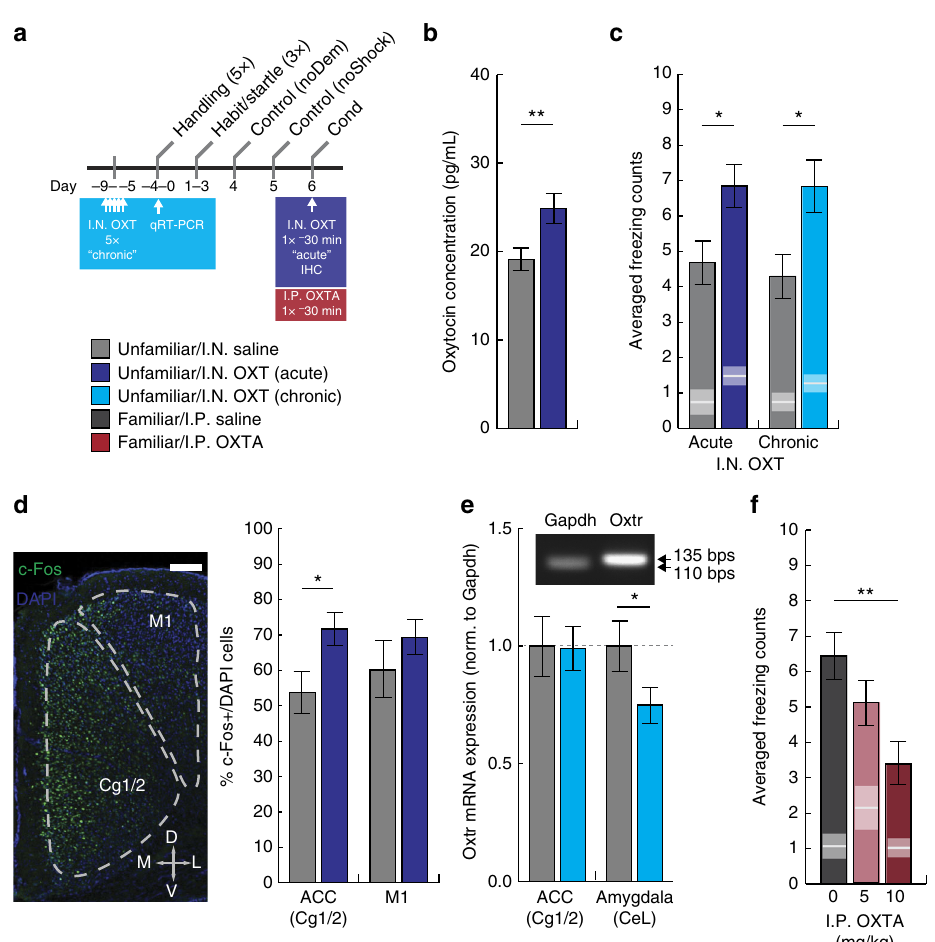
Fig. 3 Oxytocin modulates socially transmitted fear behavior and neural mechanisms. a Schematic of oxytocin drug regimens and times of sample collection for qRT-PCR and immunohistochemistry (IHC; habit, habituation; cond, demonstrator conditioning; OXT, oxytocin; OXTA, oxytocin receptor antagonist). b In behaviorally naïve mice administered acute intranasal oxytocin (20 μ g/kg; dark blue, n = 10), concentrations of the neuropeptide in CSF were signi fi cantly elevated compared to saline-treated controls (gray, n = 10) (two-tailed Student ’ s t- test: t (19) = 2.73, p = 0.015). c Unfamiliar male observers given acute (20 μ g/kg, single dose, 30 min prior; dark blue, n = 12; two-tailed Student ’ s t- test: t(23) = 2.49, p = 0.020) or chronic (20 μ g/kg, 5 daily doses; light blue, n = 11; two-tailed Student ’ s t- test: t (21) = 2.64, p = 0.016) intranasal oxytocin exhibited a signi fi cant enhancement of freezing compared to saline-treated controls (gray, n = 12/11, respectively). White lines and gray boxes within bars indicate mean and s.e.m. of freezing counts, respectively, during acclimation. d Immuno fl uorescent labeling of c-Fos+ and DAPI cells within the anterior cingulate cortex (Cg1/2) and primary motor area (M1) (scale bar, 100 μ m). Acute intranasal oxytocin signi fi cantly enhanced the percentage of c-Fos+/DAPI cells within the ACC (two-tailed Student ’ s t- test: t (9) = 2.36, p = 0.048) but not M1 (two-tailed Student ’ s t- test: t (9) = 0.96, p = 0.369) ( n = 5 mice per group). e Chronic intranasal oxytocin signi fi cantly reduced oxytocin receptor (Oxtr) transcript expression in the lateral division of the central nucleus of the amygdala (CeL) (two-tailed Student ’ s t- test: t (19) = 2.08, p = 0.05), but not the ACC (two-tailed Student ’ s t- test, t (19) = 0.06, p = 0.95), assayed one day after completion of chronic oxytocin treatment. qRT-PCR amplicons of the Gapdh (110 bps) and Oxtr (135 bps) transcripts at expected sizes. f Familiar male observers systemically administered the oxytocin receptor antagonist L-368,899 hydrochloride (OXTA; I.P. single dose, 30 min prior; red, n = 12 per group) showed dose- dependent reductions in socially transmitted fear at 5 mg/kg and 10 mg/kg, compared to saline-treated controls (ANOVA: F 2,35 = 5.73, p = 0.007). Error bars represent s.e.m. * p < 0.05; ** p < (Supplementary Fig. 8). Therefore, the effects of oxytocin on socially acquired fear were not secondary to alterations in the capacity for fear conditioning in general.